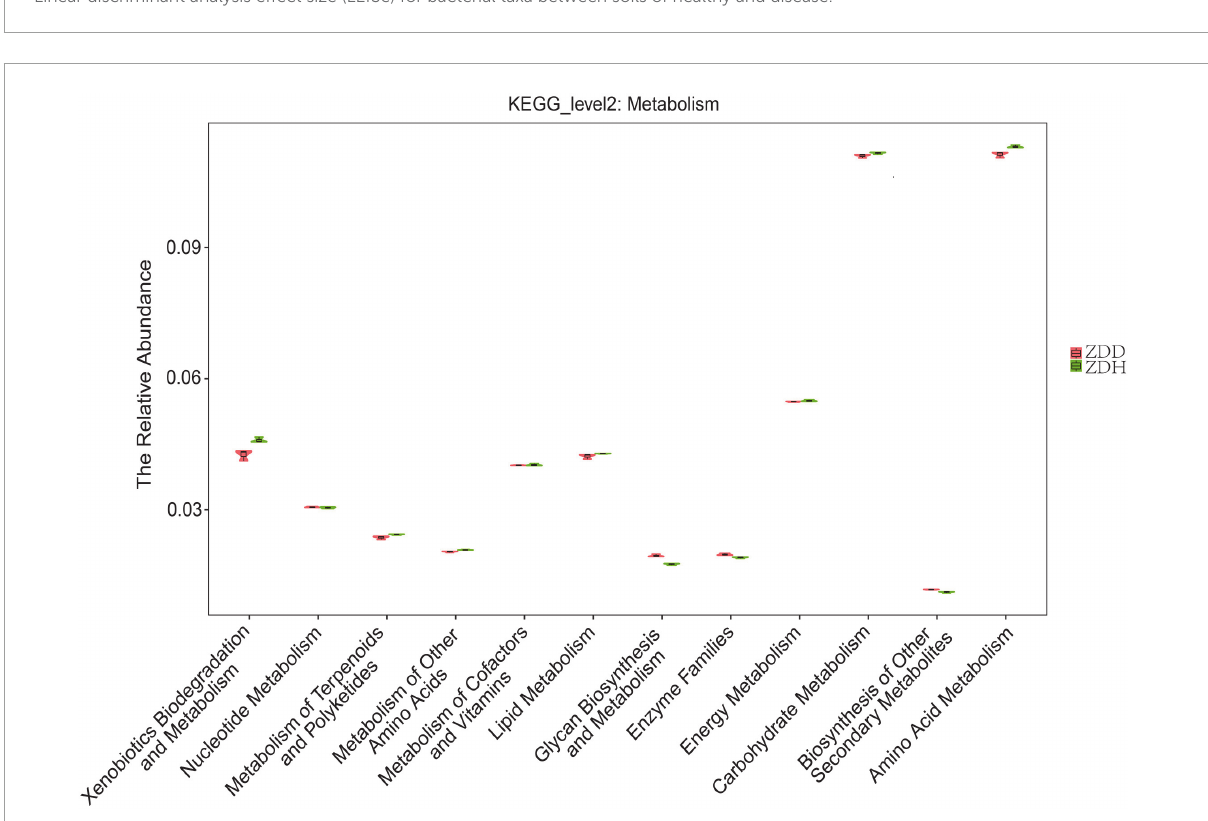
FIGURE5 Predicted metabolism functions of the bacterial communities found in maize rhizosphere soil samples. ZDD refers to rhizosphere soil with severe stalk rot disease, and ZDH refers to the rhizosphere soil with disease-free near by the ZDD.